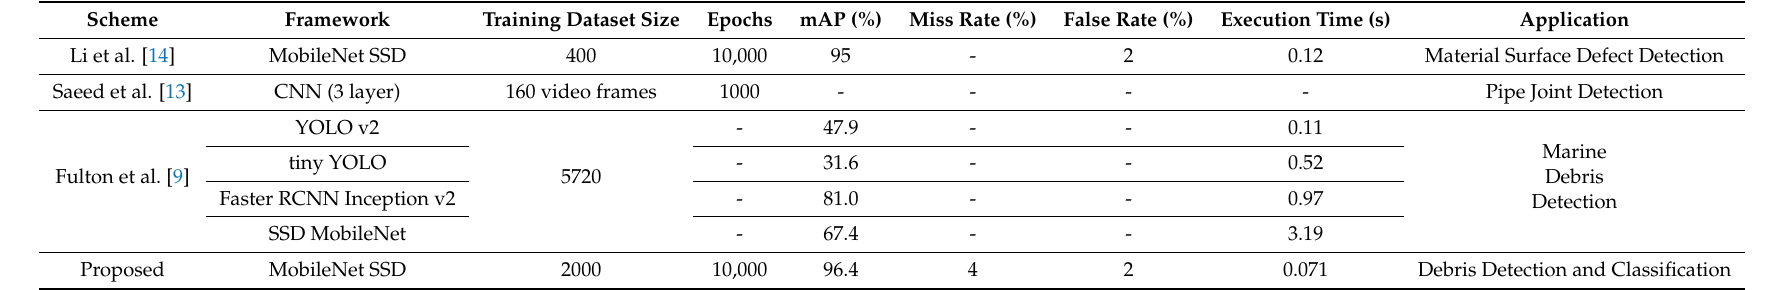
Table 6. Comparison with DL Schemes for Other